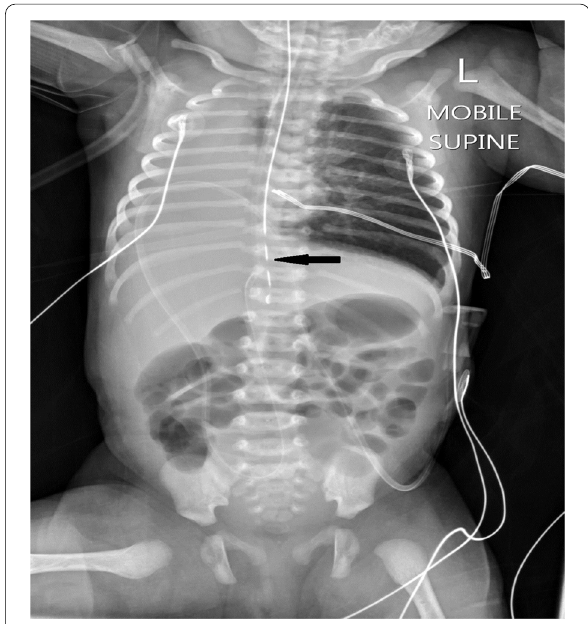
Fig. 1 Chest X-ray showing opacification of the right lung with a Replogle tube (black arrow) terminating at the level of the 11th thoracic vertebra